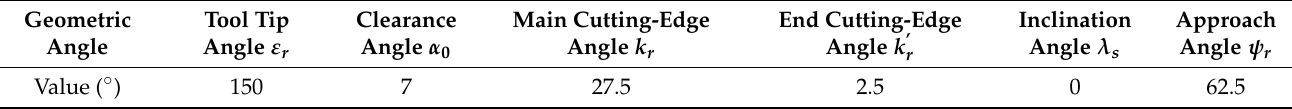
Table 1. Geometric angles of the tool.